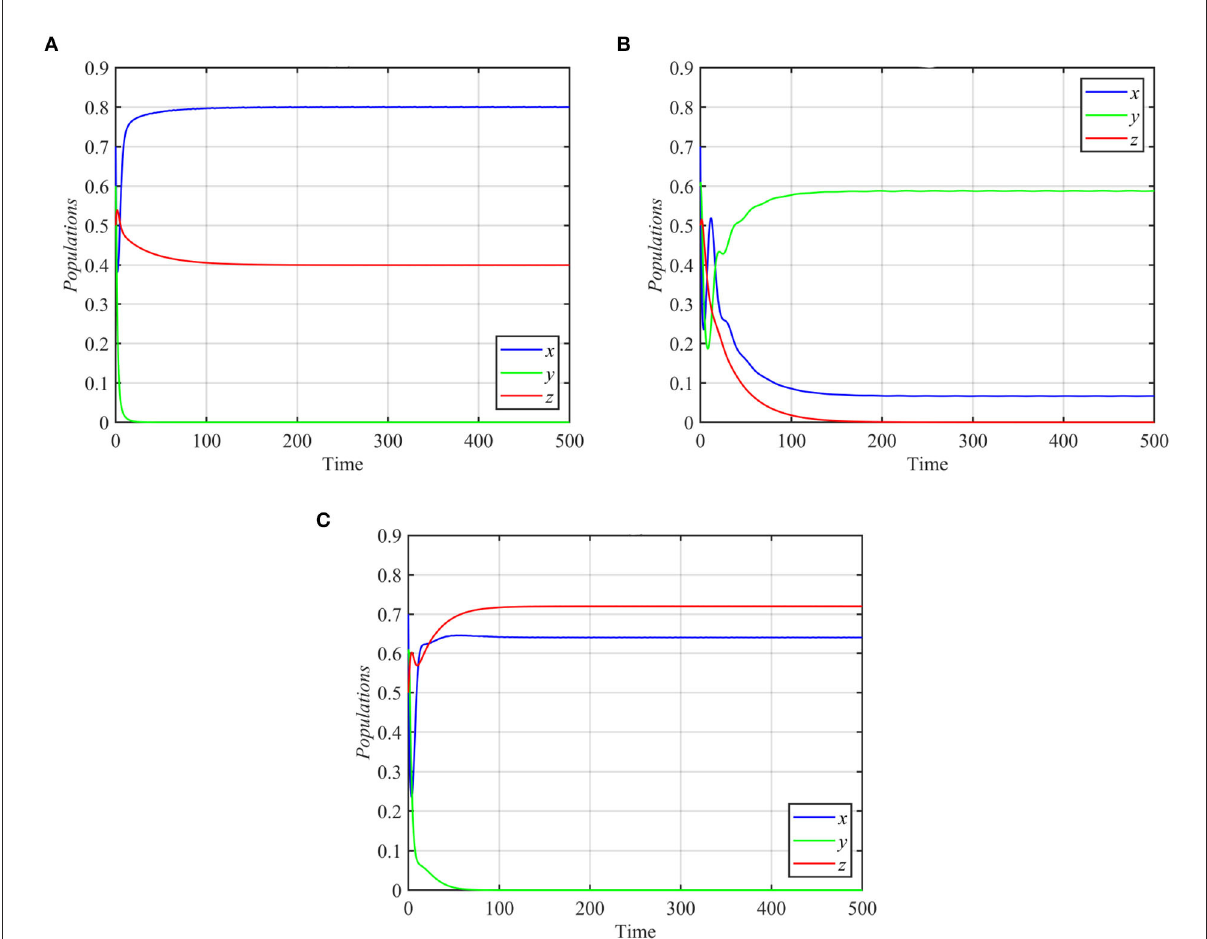
FIGURE6 Trajectories of system (1) for different values of d 1 and d 2 , with other parameters as in equation (17). (A) Time series for trajectories of x , y , and z for d 1 0.4, which approach E 2 (0.8,0,0.4). (B) Time series for trajectories of x , y , and z for d 2 = = Time series for trajectories of x , y , and z for d 2 0.08, which approach E 2 =